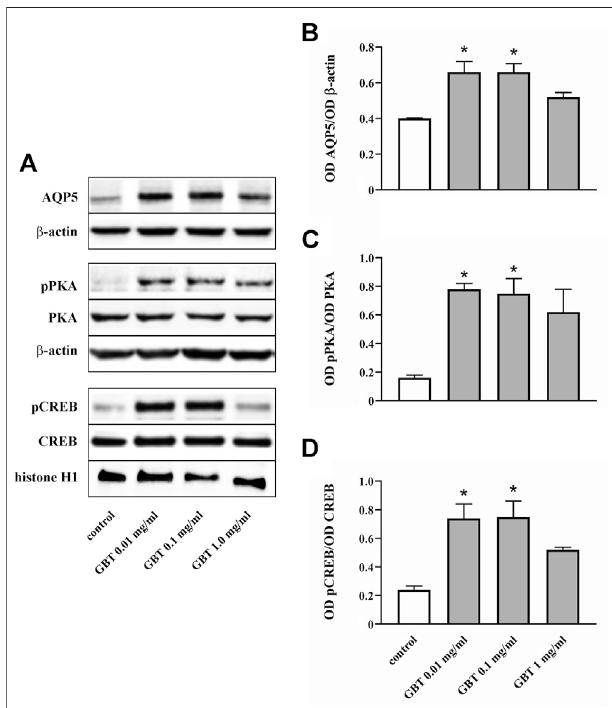
FIGURE 7 | Level of AQP5 and downstream mediators in HCE-F cells treated with GBT at 0.01, 0.1 or 1 mg/ml. (A) Representative blots depicting levels of AQP5, pPKA, PKA, pCREB, and CREB after treatment with GBT as determined by Western blotting. (B-D) Densitometric analysis of the respective levels. The expression of AQP5 was relative to the loading control β -actin, while the expression of pPKA and pCREB was normalized to the level of PKA and CREB, respectively. Data are plotted as mean ± SEM. Differences betweengroupsweretestedforstatisticalsigni fi canceusingone-wayANOVA with Tukey ’ s multiple comparison post-test. * p < 0.05 relative to control ( n (cid:2) 5).